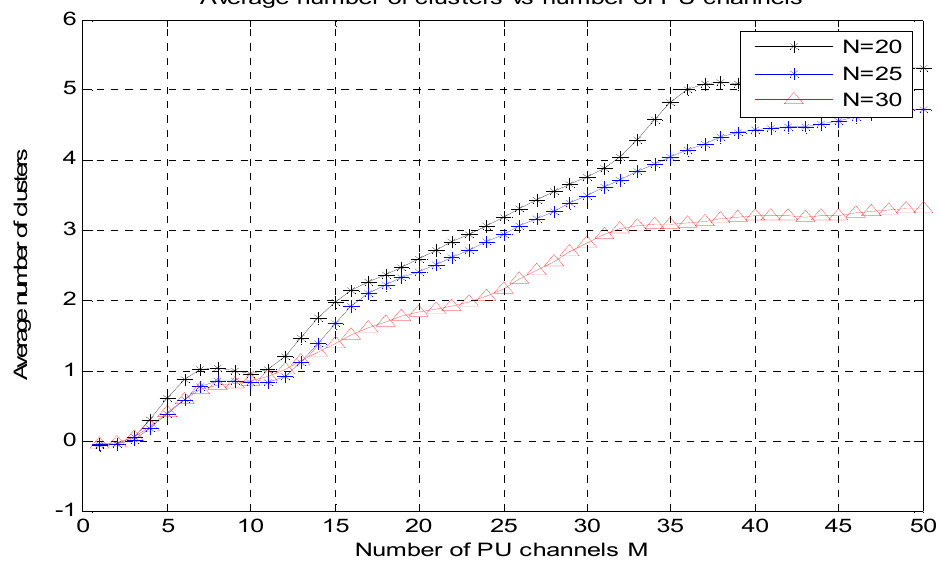
Figure 4. Number of PU channels (M) vs. average number of clusters.